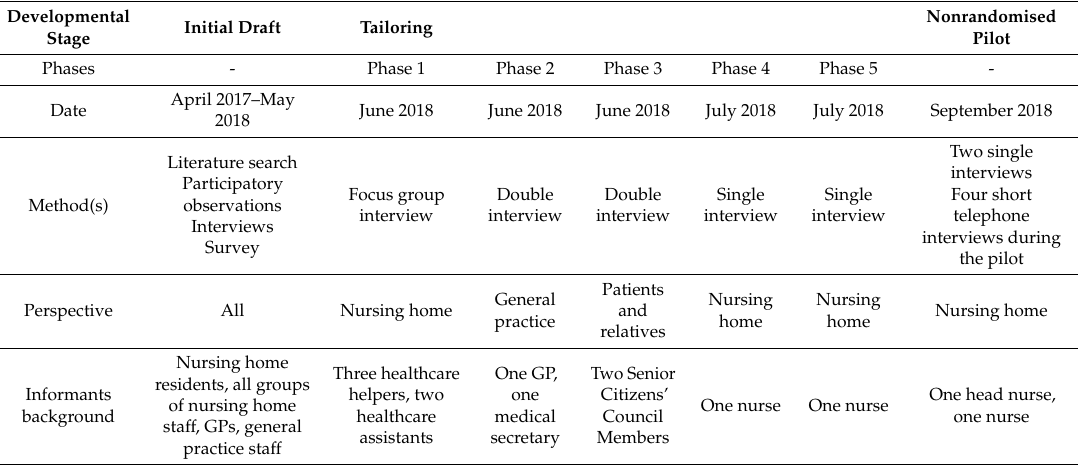
Table 2. Developmental stages from the original idea to the final intervention of the dialogue